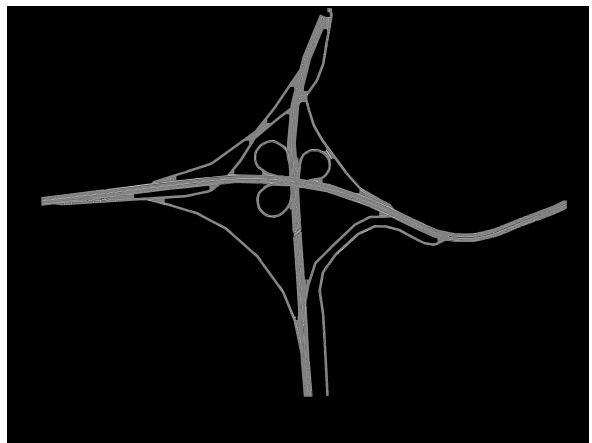
Figure 15: Texture image of whole imagery.